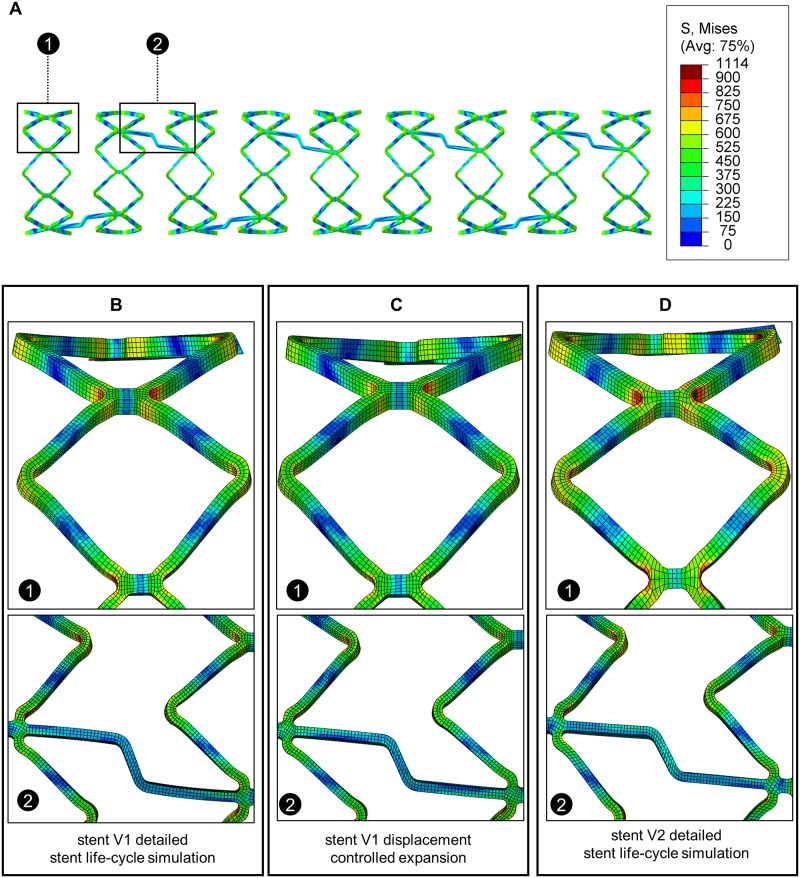
Comparison of stress distribution in the maximum expanded state.A: Overview of the stress distribution and localization of the following close-up representations. B: Stress distribution obtained from the detailed stent life-cycle simulation of stent V1. C: Stress distribution obtained from the displacement controlled expansion simulation of stent V1. D: Stress distribution obtained from the detailed stent life-cycle simulation of stent V2.